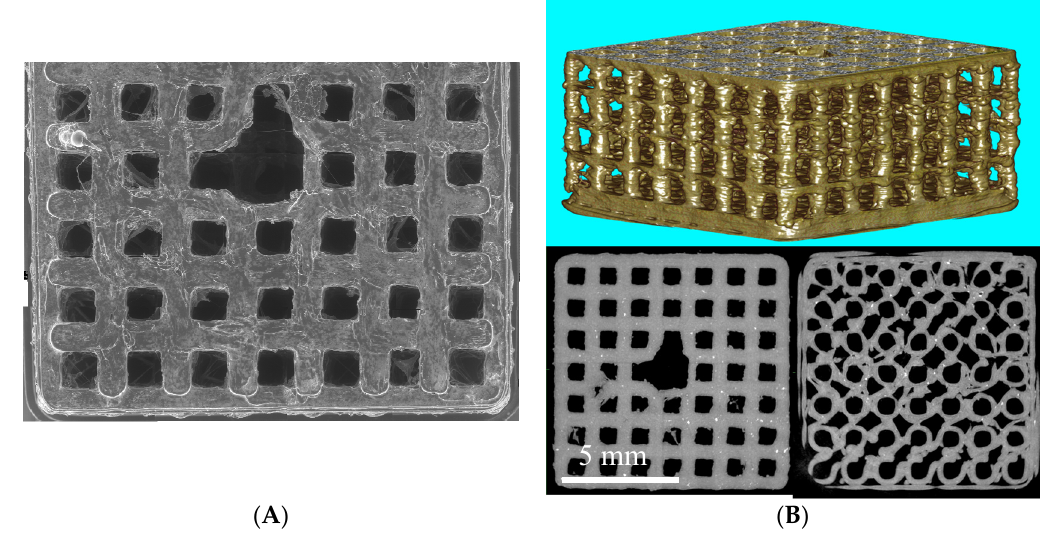
Figure 1. ( A ) Scanning electron microscope (SEM) image gallery of the PLA scaffolds. Single Images (100×) are stacked together manually; ( B ) µCT 3D volume rendering of polylactide (PLA) cage and µCT-slices as multiplanar reconstruction (MPR) images from the top and bottom site of the PLA cage.